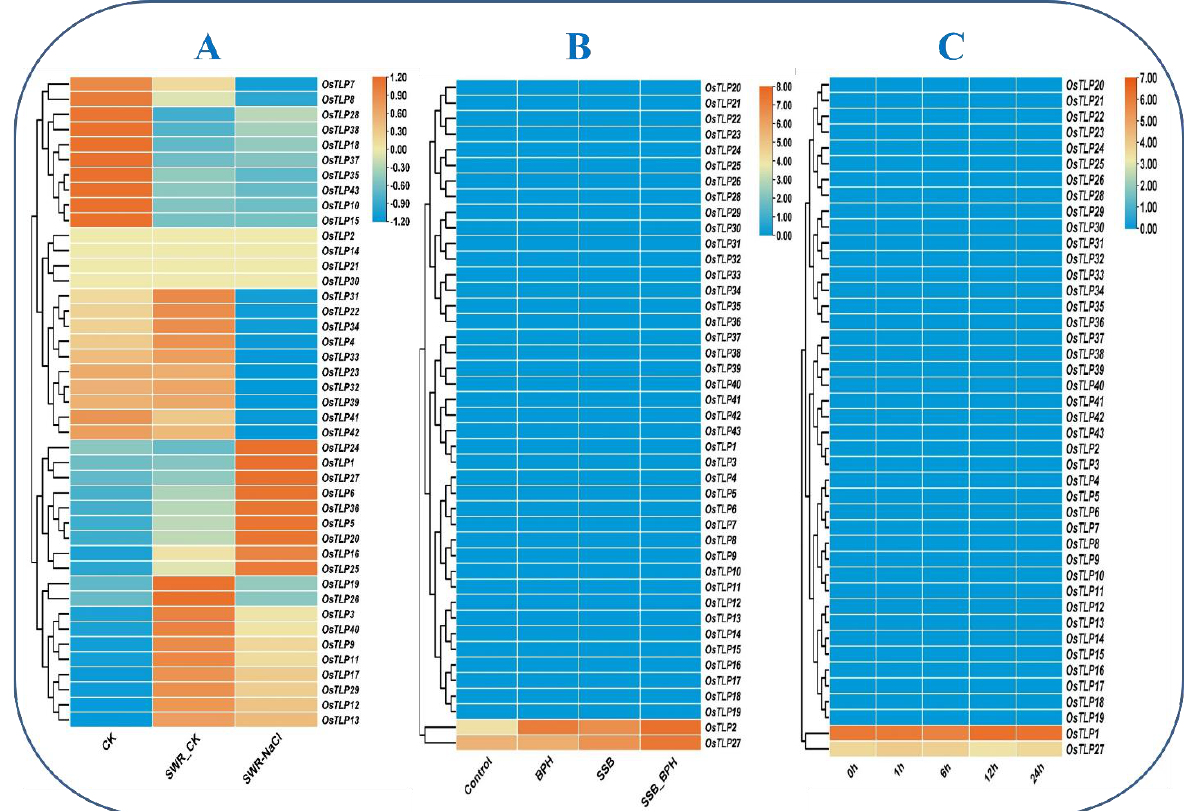
Figure 7. Heatmap under salinity and biotic stresses. Heatmap ( A ) represents OsTLP gene expression in CK, SWR_CK, and SWR_NaCl. Heatmap ( B ) represents the OsTLP gene expressions in shoot tissues under BPH, SSB, and SSB_BPH. Heatmap ( C ) represents response to Cnaphalocrocis medinalis stress at different time points in Oryza sativa . The log2 transformation method normalized and converted the RPKM values displayed.